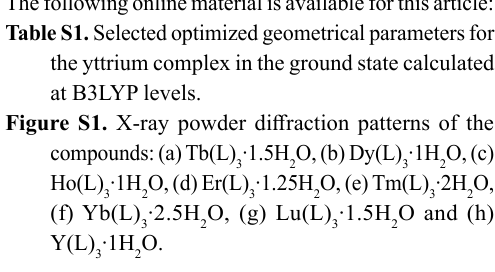
Table S1. Selected optimized geometrical parameters for the yttrium complex in the ground state calculated at B3LYP levels. Figure S1. X-ray powder diffraction patterns of